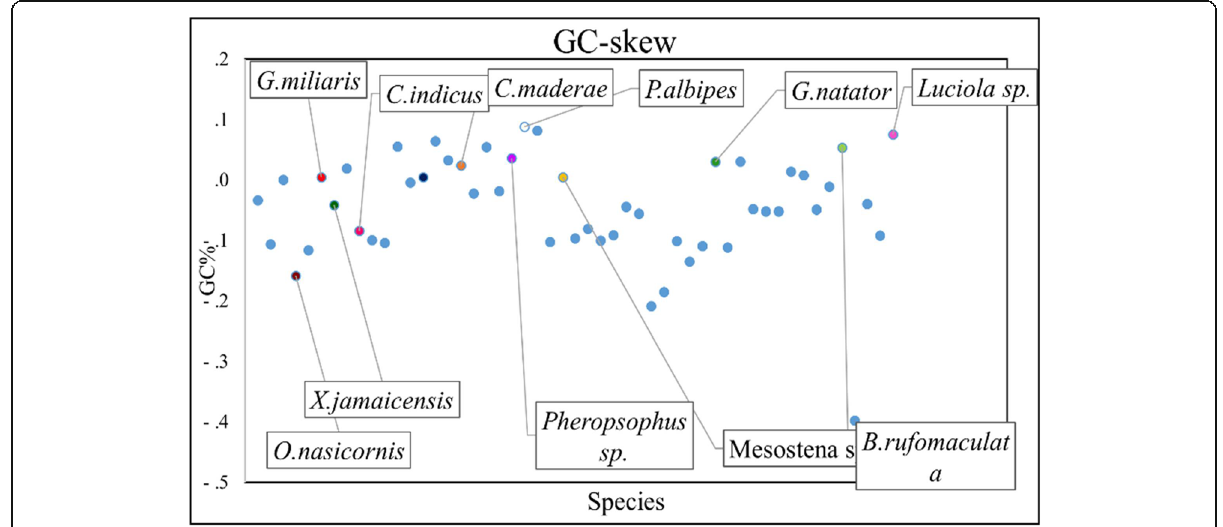
Fig. 5 GC skew of all the species in study is calculated with predefined formula as mentioned in materials and method. The species sequenced are highlighted in the graph. Luciola sp. had the maximum value of + 0, while the lowest was of O.nasicornis. G.miliaris , C.maderae , P.albipes ,